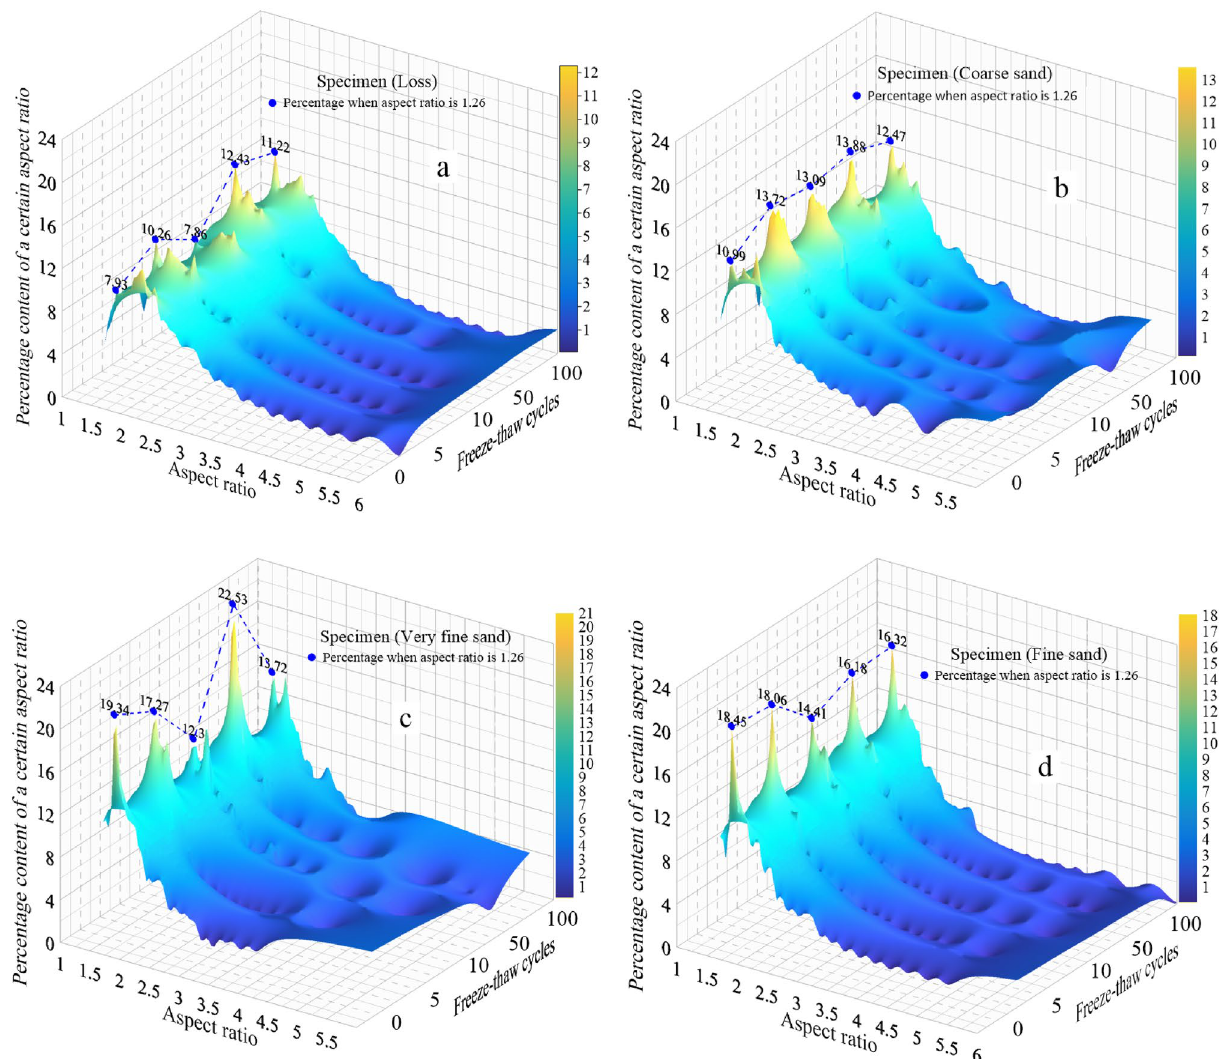
Figure 3. The percentage content change of a certain aspect ratio of four soil specimens after different freeze– thaw cycles. ( a Specimen(L); b Specimen (CS); c Specimen (VFS); d Specimen